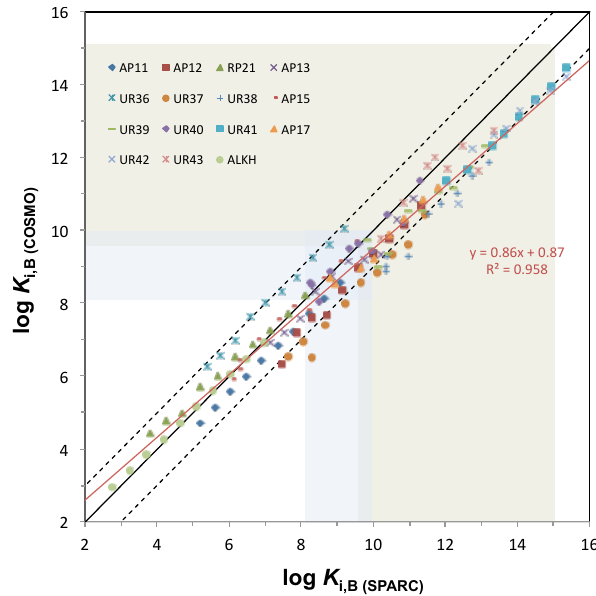
Figure 9. Plot comparing the partition coefficients at 25 ◦ C of alka- nes and their oxidation products between the Kalberer et al. (2004) structure B and the gas phase predicted with SPARC and COSMO- RS. For a definition of the chemical codes in the legend, see Fig.